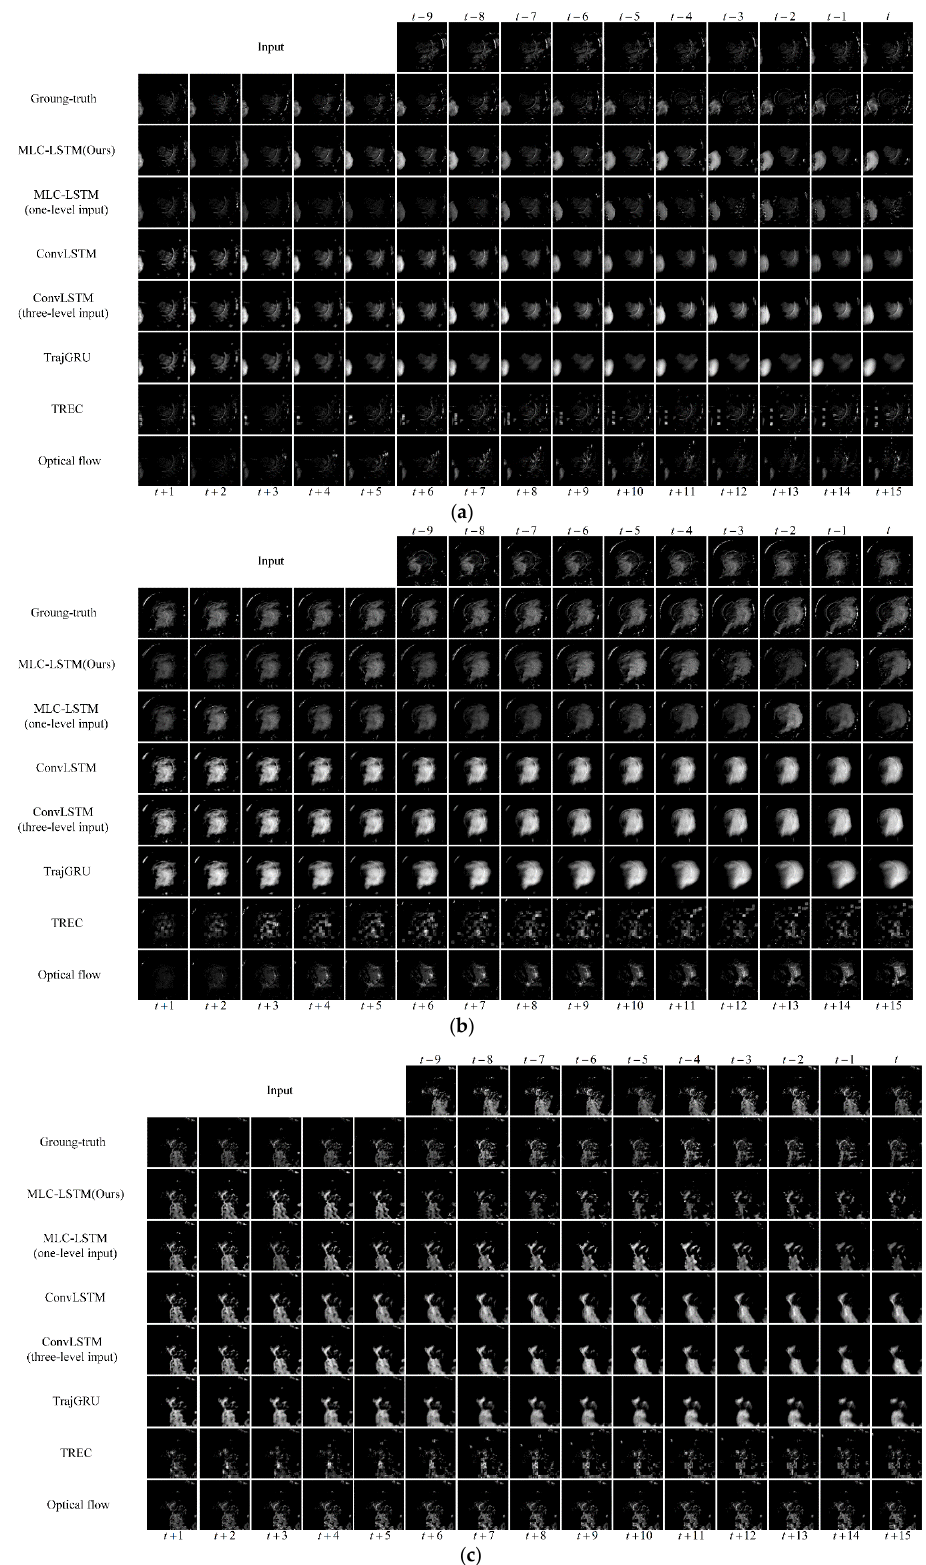
Figure 9. Three extrapolation samples predicted by seven models. ( a ) An echo advection motion process at Nanjing, China, 6 September 2016, 10:20 UTC; ( b ) An echo formation process at Nanjing, China, 6 September 2016, 13:54 UTC; ( c ) An echo dissipation process at Hangzhou, China, 8 August 2016, 23:07 UTC. Table 6. Quantitative evaluation results of seven models on six metrics. The mean value of six metrics of 5, 10, and 15 extrapolation steps is reported, respectively (corresponding to 0.5, 1, and 1.5 h). ( a ) Evaluation results on the probability of detection (POD) and false alarm rate (FAR); ( b ) Evaluation results on the critical success index (CSI) and Heidke skill score (HSS); ( c ) Evaluation results on the structural similarity index measure (SSIM) and peak signal to noise ratio (PSNR).